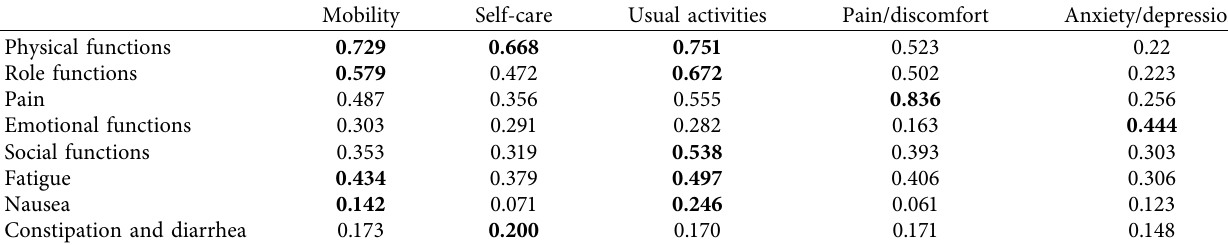
Table 7: Correlations between EORTC QLQ-C30 and EQ-5D-5L